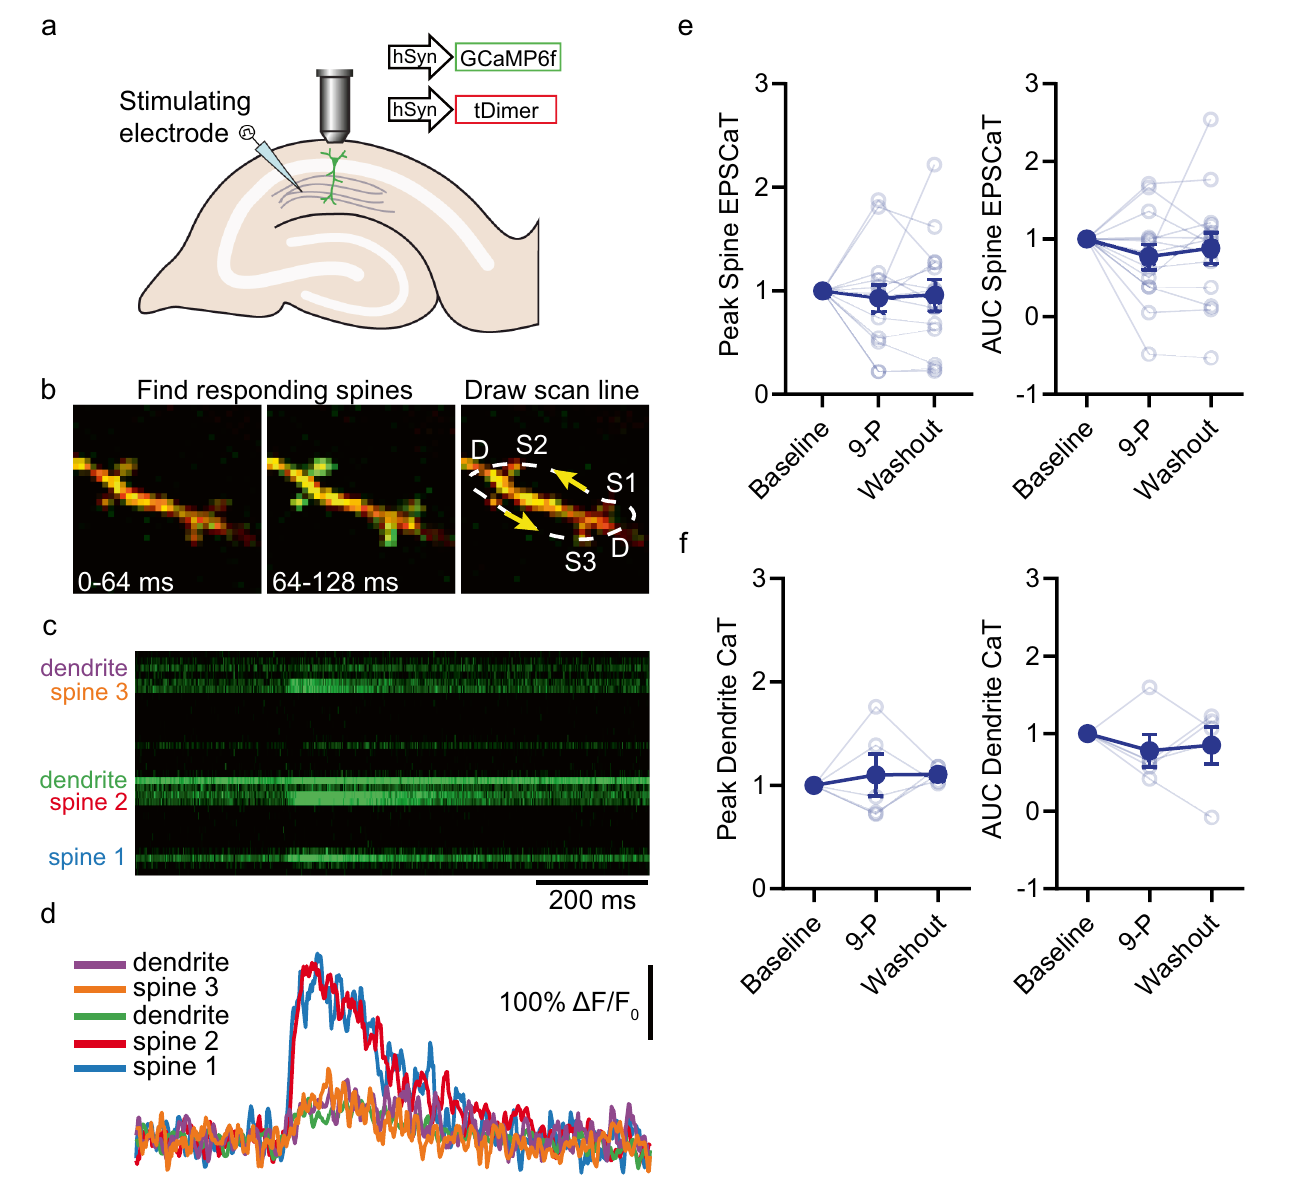
Figure 1. 9-phenanthrol does not reduce evoked excitatory postsynaptic calcium transients. ( a ) A monopolar stimulating electrode was placed in stratum radiatum to stimulate the Schaffer collateral axons and evoke EPSCaTs in spines and dendrites of CA1 neurons expressing GCaMP6f. and tdimer2. EPSCaTs were recorded using a two-photon microscope. ( b ) Example trial in frame scan mode of an EPSCaT from responding spines (64–128 ms) and the corresponding arbitrary scan line passing through spines 1–3 and twice through the dendrite. ( c ) Example EPSCaTs in response to Schaffer collateral stimulation from the line in B. ( d ) Calcium transients of the individual spines from the linescan in C. ( e ) Baseline normalized spine EPSCaT peak and area under the curve (AUC) from 5 min. at baseline, during wash-in of 9-phenanthrol (9-P, 30 µM, last 5 min.) and following washout (n = 14 spines, individual responses, mean ± SEM). ( f ) Baseline normalized peak and AUC of dendritic calcium transients (CaTs). Individual dendritic responses are the average from two linescan crossings (n = 5 dendrites, individual responses, mean ±